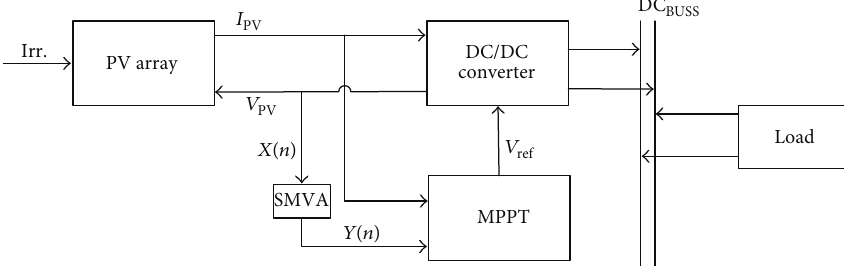
Figure 2: Proposed simple moving voltage average (SMVA) with incremental conductance MPPT